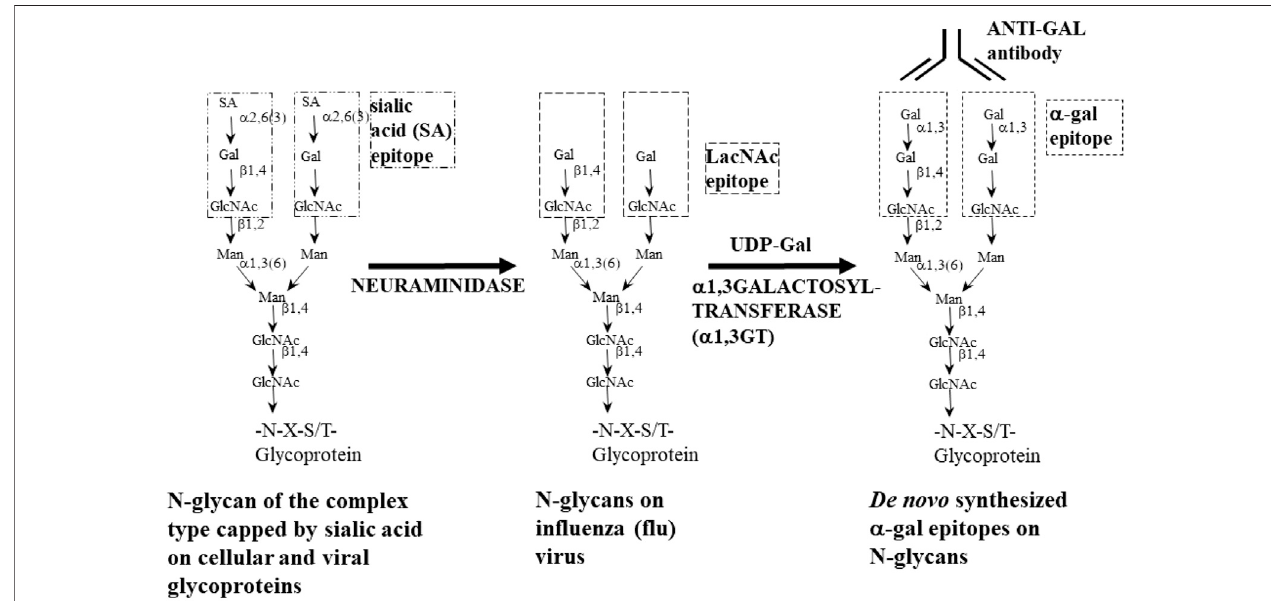
FIGURE 2 | Enzymatic synthesis of α -gal epitopes on N-glycans of nucleated cells and of viruses lacking this epitope. Left glycan — glycan of the complex type capped by sialic acid (SA). Center glycan — sialic acid is removed from the glycan by neuraminidase to expose the penultimate Gal β 1-4GlcNAc-R called N-acetyllactosamine (LacNAc). Right glycan — the α -gal epitope (Gal α 1-3Gal β 1-4GlcNAc-R) is synthesized by natural or recombinant α 1,3galactosyltransferase (r α 1,3GT) which links galactose provided by the sugar donor uridine diphosphate galactose (UDP-Gal) to Gal β 1-4GlcNAc-R. In in fl uenza virus, sialic acid is removed by the viral neuraminidase; thus, no neuraminidase is required. Adapted from Abdel-Motal et al. (2006), with permission.